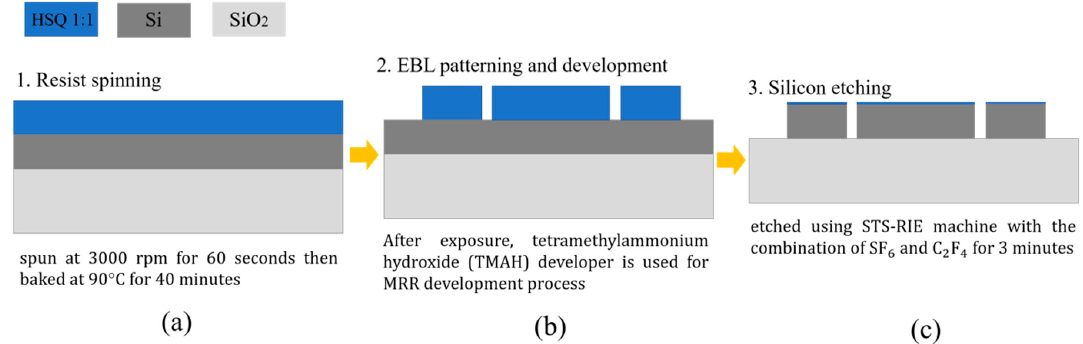
Figure 2. Three steps of the device fabrication process as follows: ( a ) resist spinning, ( b ) Electron Beam Lithography (EBL) patterning and development, and ( c ) silicon